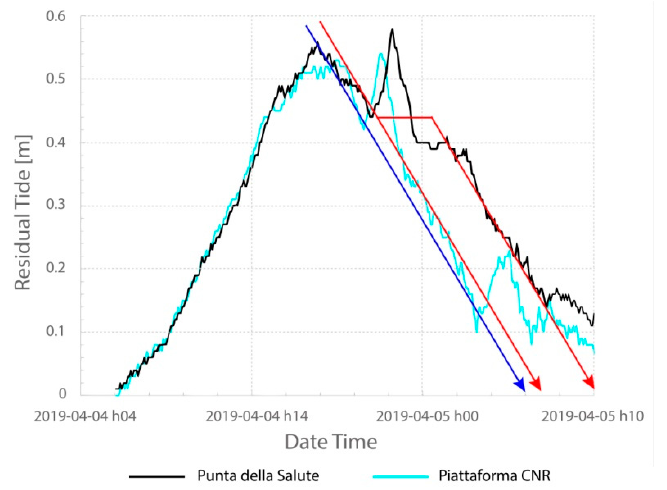
Figure 2. Residual tide over “Piattaforma CNR” and “Punta salute” stations, on 4–5April 2019.Blue and red arrows represent the linear tidal trend(time is expressed in UTC+1).